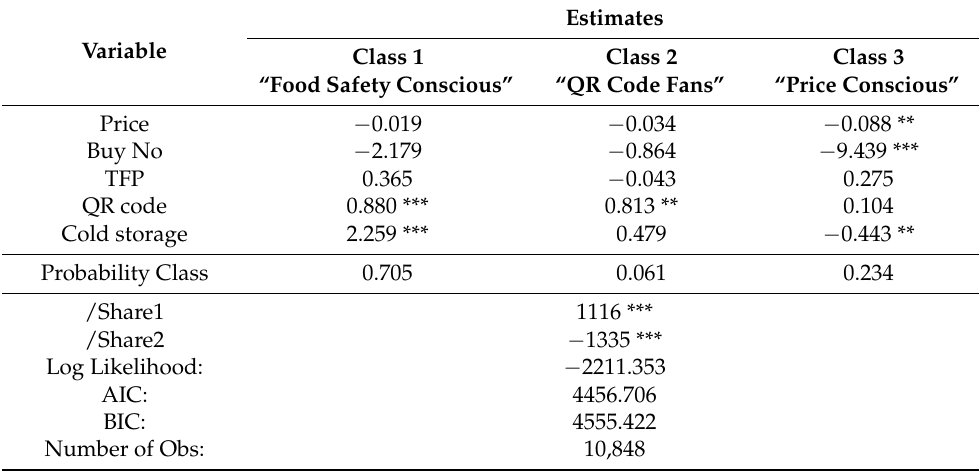
Table 6. Estimated results of the